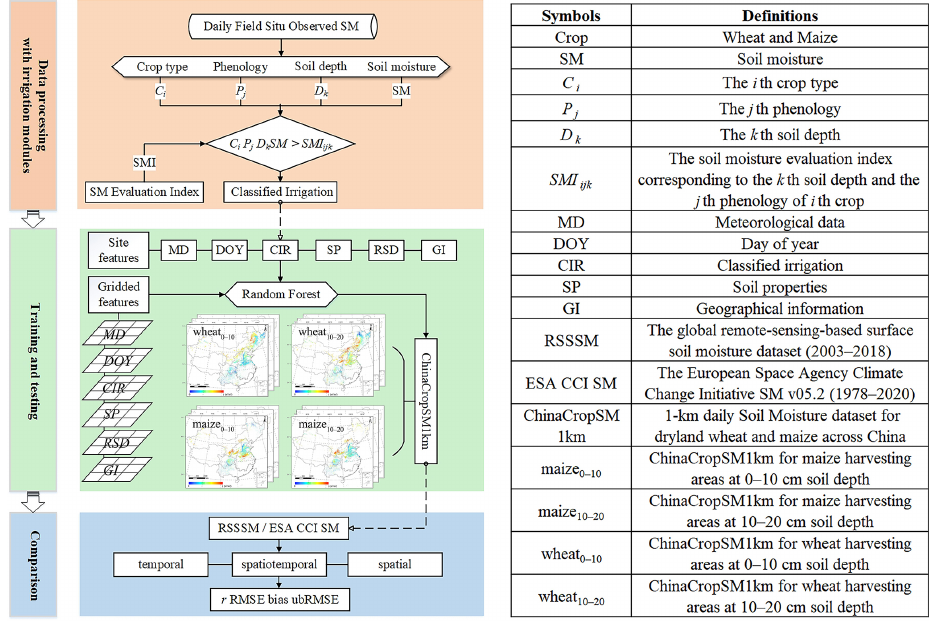
Figure 2. Flow chart for producing ChinaCropSM1 km with an irrigation